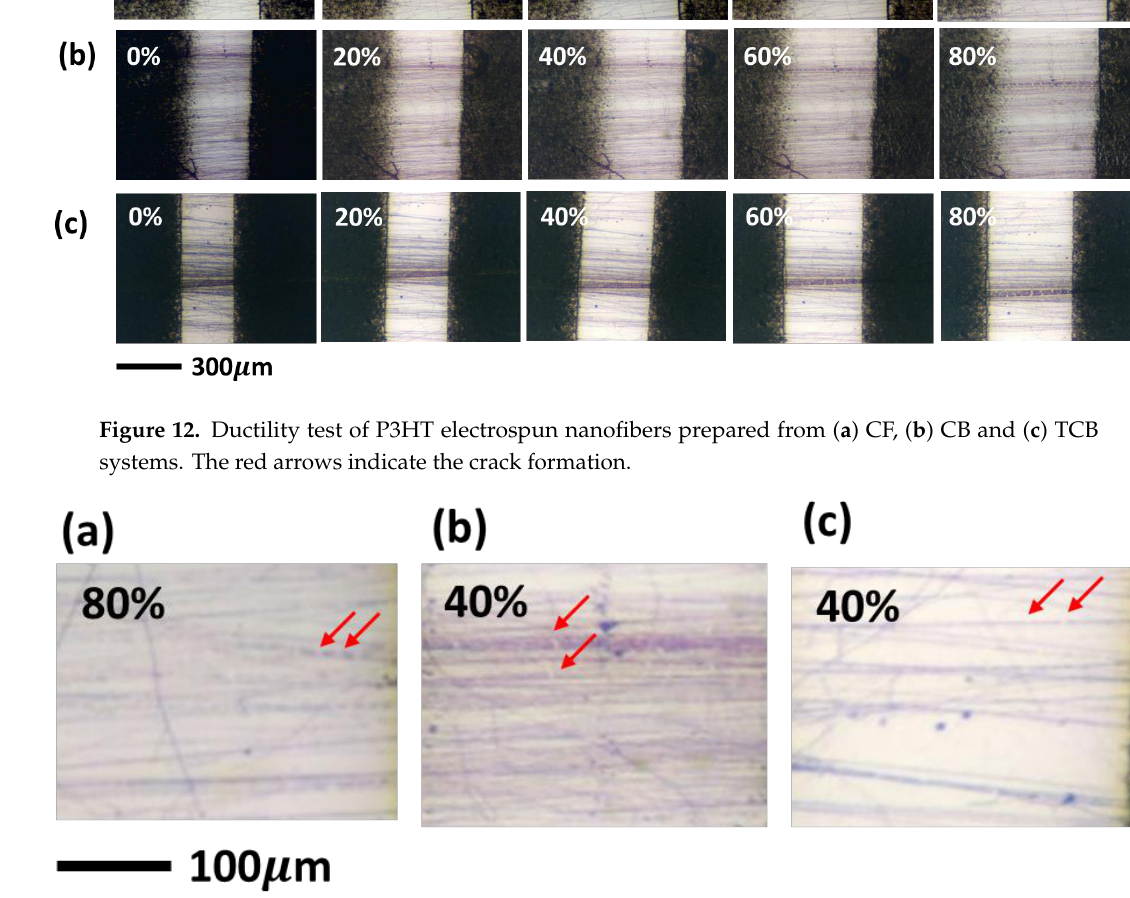
Figure 13. Enlarged optical images of crack formation for ( a ) CF, ( b ) CB and ( c ) TCB system. The red arrows demonstrate the location of crack formation.